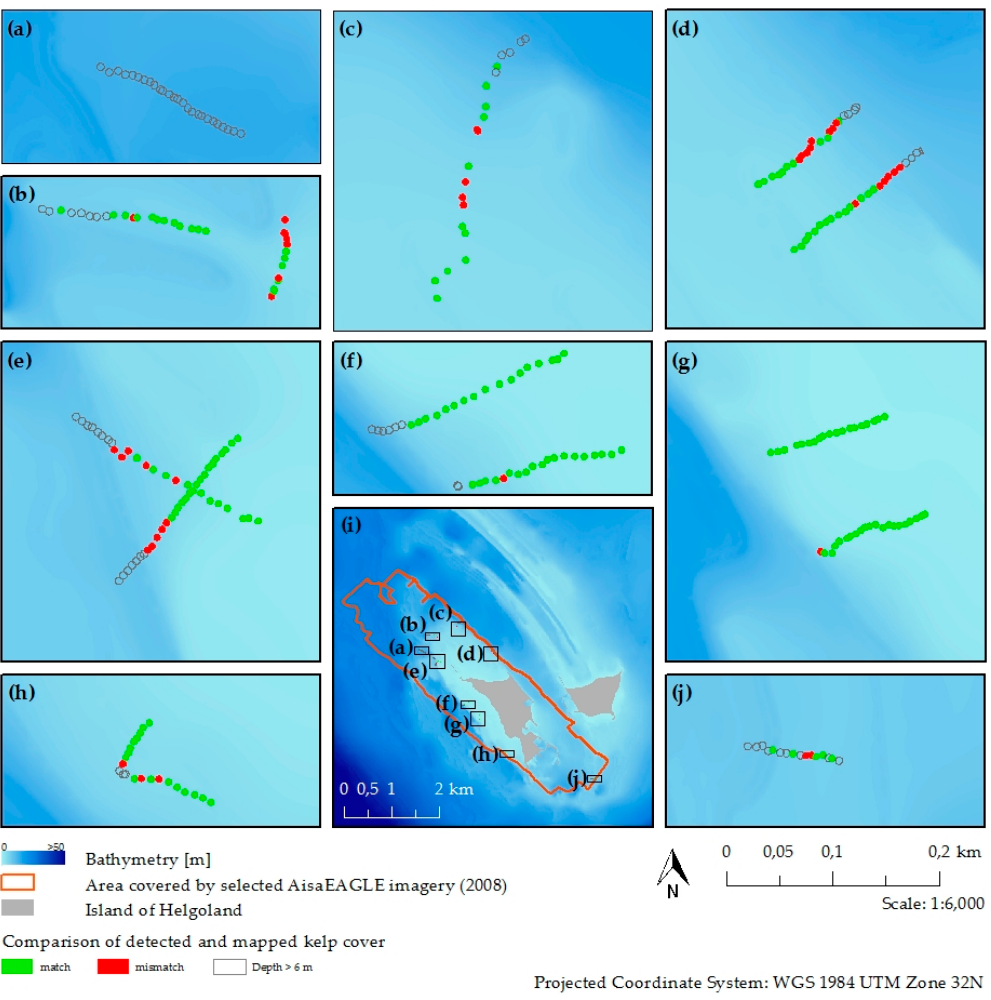
Figure 7. Kelp detection validation results with diving transect mapping ( a – h ), cover of the selected flight stripes ( i ) and kelp detection validation results ( j ).